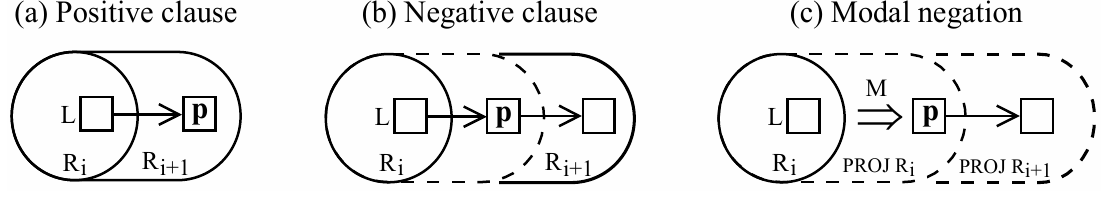
Figure 7. Clausal polarity options.